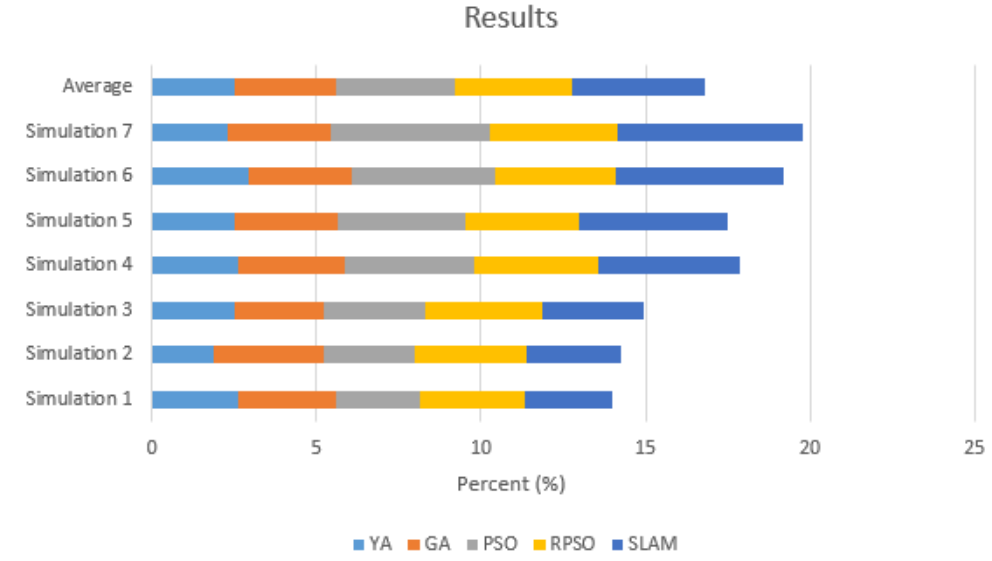
Figure 21. Error Rates for Different Simulation